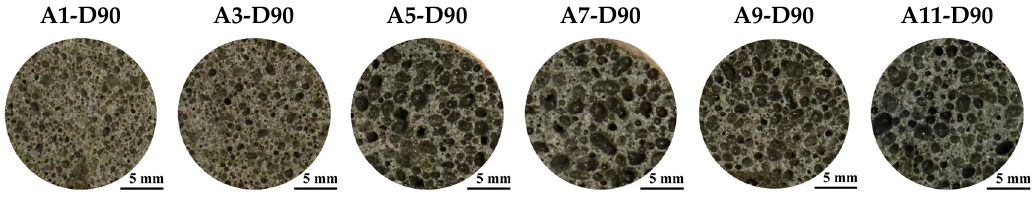
Figure 9. Cross-sectional images of samples with different carbon contents at 1200 ◦ C for 20 min.